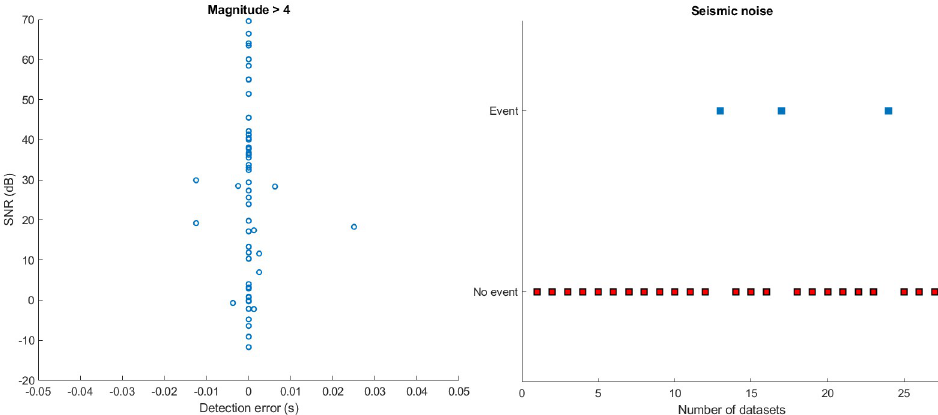
Fig 11. Detection error. The left plot depicts the detection rate of the proposed algorithm for high SNR > 1 dB. The right plot shows the false alarm rate of the proposed method for background noise, where the red square box indicates no detection in the noise and blue boxes indicate false detection of events in background